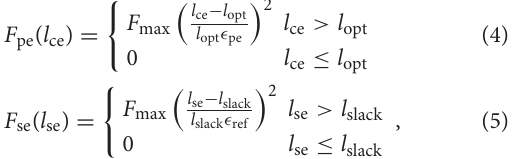
the muscle characteristics and reflexes. The motor driver